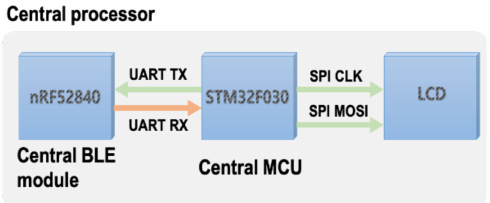
Figure 4. Central processor block